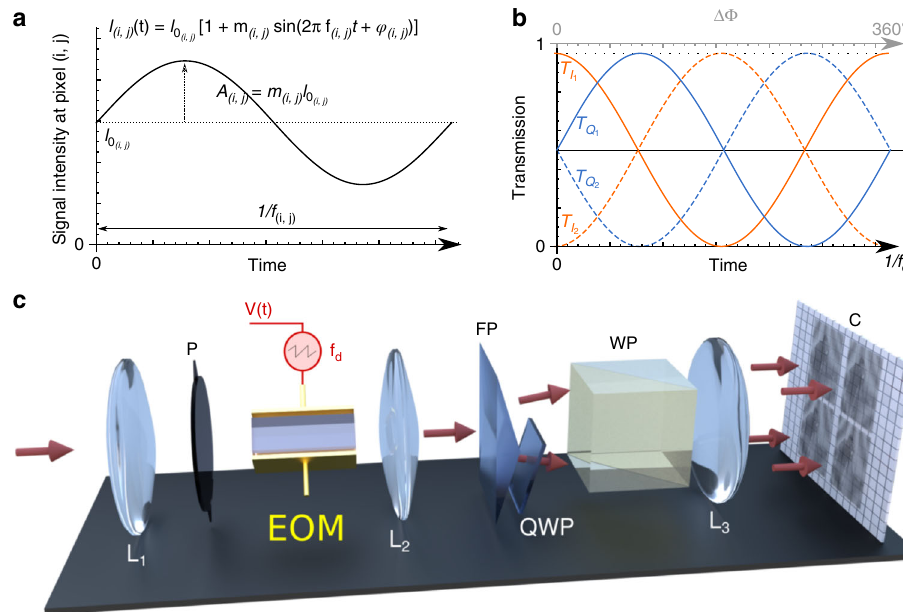
Fig. 1 Principle of quadrature demodulation imaging and FAST-QUAD concept. a At a given location (pixel) ð i ; j Þ of the scene, the input light is assumed to be intensity-modulated at frequency f ð i ; j Þ with modulation index m ð i ; j Þ , over a mean (DC) intensity component I incoming light is demodulated at frequency f by product demodulation through four transmission-modulated optical gates along four quadratures ( T I d T T I 2 , Q 2 ). It is then time-averaged on the camera over the exposure time of a frame, and the four intensity values ( pixel allow the average (DC) intensity I the result of product demodulation, at frequency f , of the incoming light with speci fi c phases (0 (cid:1) , 90 (cid:1) , 180 (cid:1) , and 270 (cid:1) ). From these four sub-images, the d average (DC) intensity and the modulation amplitude and phase maps can be obtained in a snapshot manner from a single acquired frame. To achieve this instantaneously and optically, the input light/image is passed through a lens L 1 , a polarizer (P), and an electro-optic (EO) crystal driven by a high-voltage , which results in an optical phase difference excursion over 360 (cid:1) between two orthogonal polarization components of light. sawtooth signal at frequency f d After collimation through lens L 2 , the beam is split by a Fresnel bi-prism (FP), with the lower beam undergoing an additional 90 (cid:1) optical phase shift passing through a quarter-wave plate (QWP). A polarizing Wollaston prism (WP) and a lens L 3 complete this 4-channel voltage-controlled sinusoidally varying optical transmission